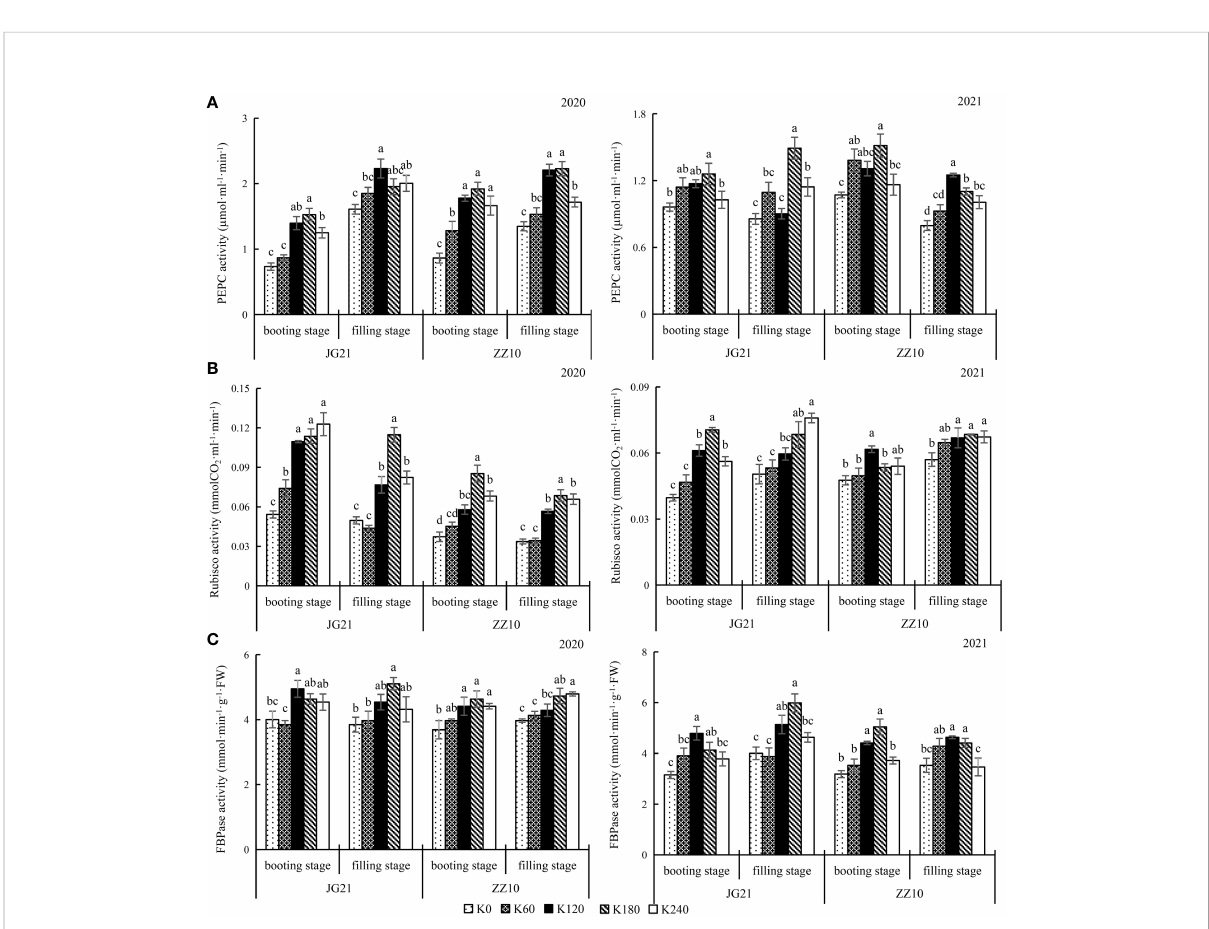
FIGURE 3 Effects of potassium application rate on key enzymes of carbon assimilation and FBPase of foxtail millet cultivars, Jingu 21 (JG21) and Zhangza 10 (ZZ10). Potassium applications include 5 level 0 (K 0 ) as control, 60 (K 60 ), 120 (K 120 ), 180 (K 180 ), and 240 (K 240 ) kg·hm − 2 of K 2 O. The different normal letters indicate signi fi cant differences in different treatments of the same variety at the 0.05 level. Values are means ± SE (n = 3). (A) PEPC, phosphoenolpyruvate carboxylase. (B) Rubisco, ribulose-1,5-bisphosphate carboxylase-oxygenase. (C) FBPase, Fructose-1,6-